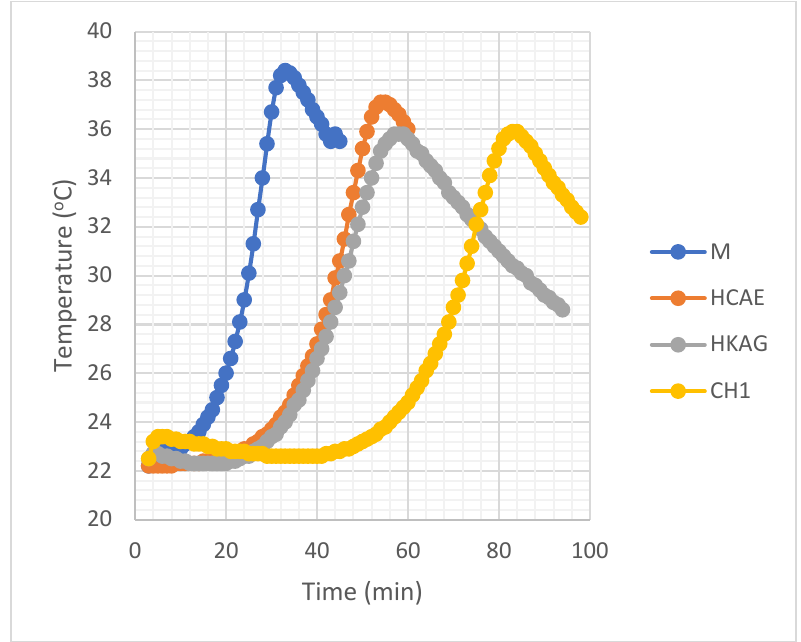
Figure 10. The evolution of the temperature in the gypsum paste in the quasi-diabatic precinct (M-Control sample).